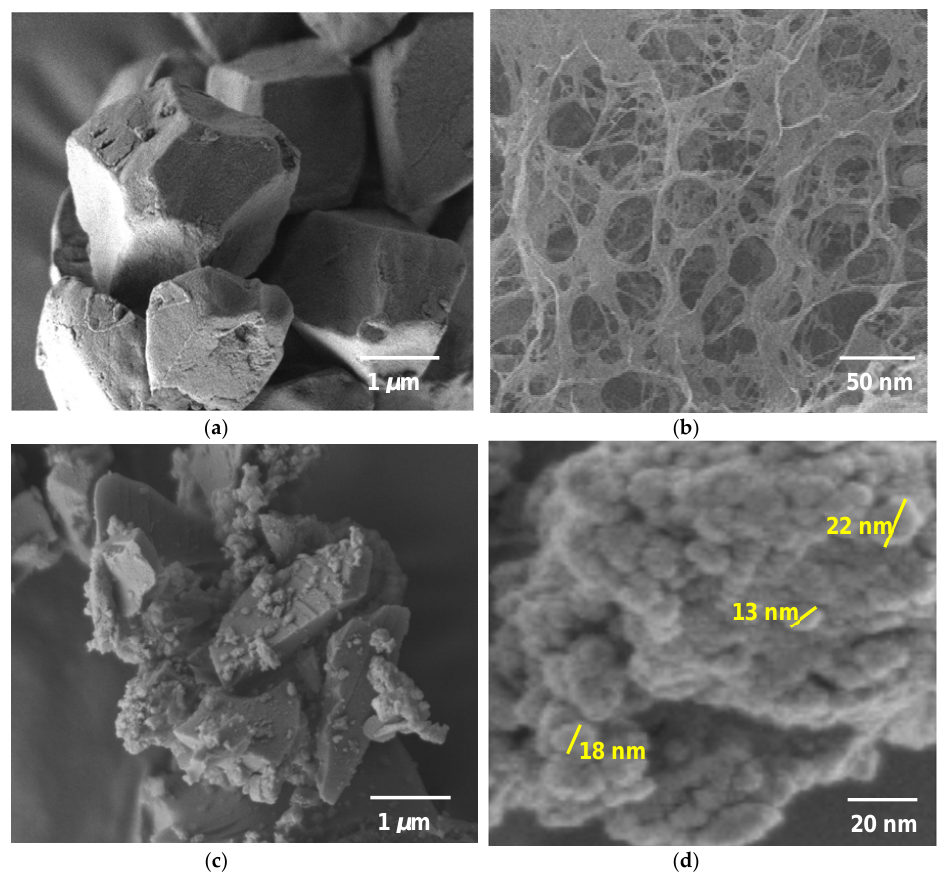
Figure 5. Field emission scanning electron microscopy (FESEM) micrograph of ( a ) RS; ( b ) RS-gel; ( c ) SG-HRS; and ( d ) SiNS.